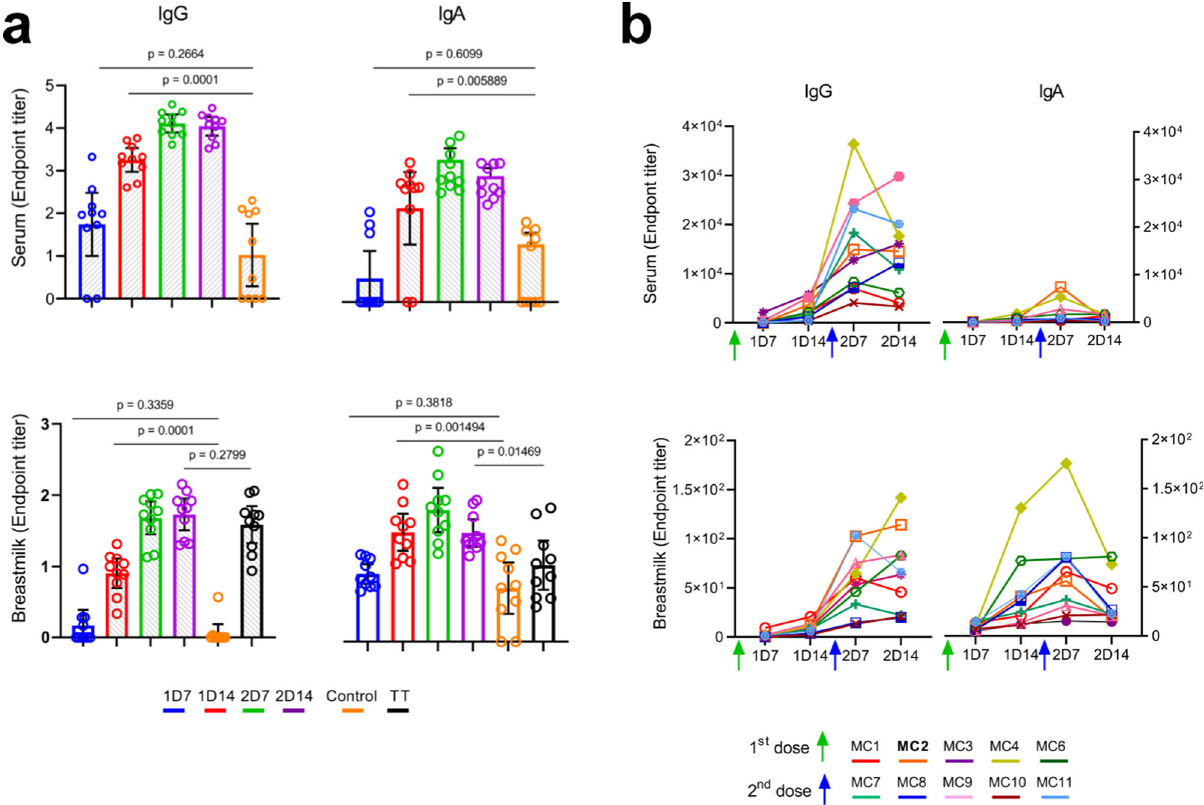
Fig. 1 Endpoint titers of spike-speci fi c IgG and IgA. a Endpoint titers were interpolated by applying a four-parameter logistic curve on reciprocal dilution series for IgG and IgA for all serum and breastmilk samples at four time points (by color) and for tetanus toxoid (TT)-speci fi c IgG and IgA in breastmilk. P values were determined with an unpaired, two-sided Mann − Whitney U-test after applying Bonferroni correction; P < 0.0125 was considered statistically signi fi cant. Results are presented as geometric means and 95% con fi dence intervals. Y -axis units are endpoint titers on a logarithmic scale. Control serum ( n = 10) and breastmilk samples ( n = 10) were obtained from healthy women before the COVID-19 pandemic. b Endpoint titers per participant, each shown in a different color. Green and blue arrows indicate the time points of administration of the fi rst ( t = 0) and second ( t = 21) vaccine doses, respectively. Y -axis units are endpoint titers on a linear scale. Source data are provided as a Source Data fi